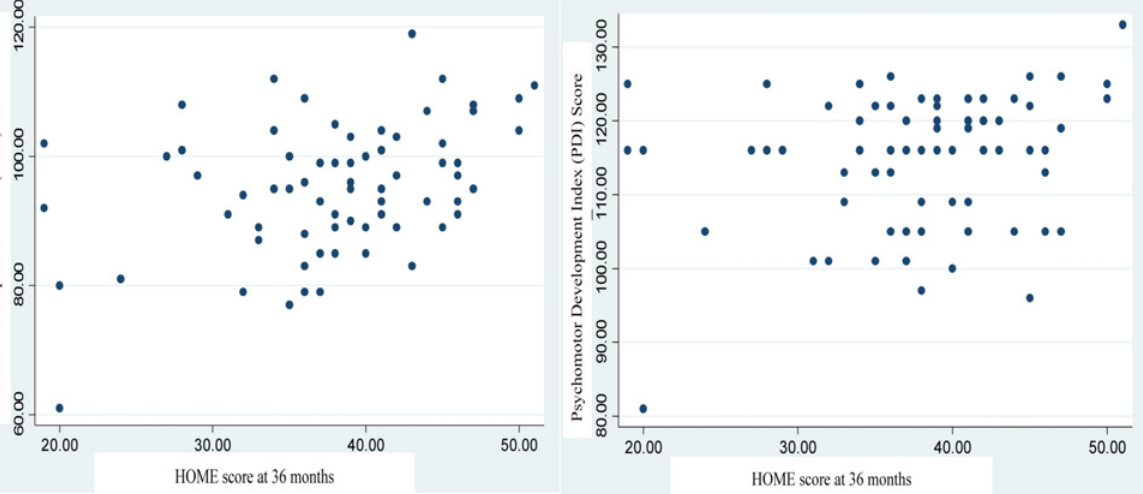
Fig 1. BSID II cluster scores (MDI and PDI) by HOME score are shown. BSID II: Bayley Scale of Infant Development, Second Edition. HOME Score: Home Observation for Measurement of Environment scale score. MDI: Mental Development Index, PDI: Psychomotor Development